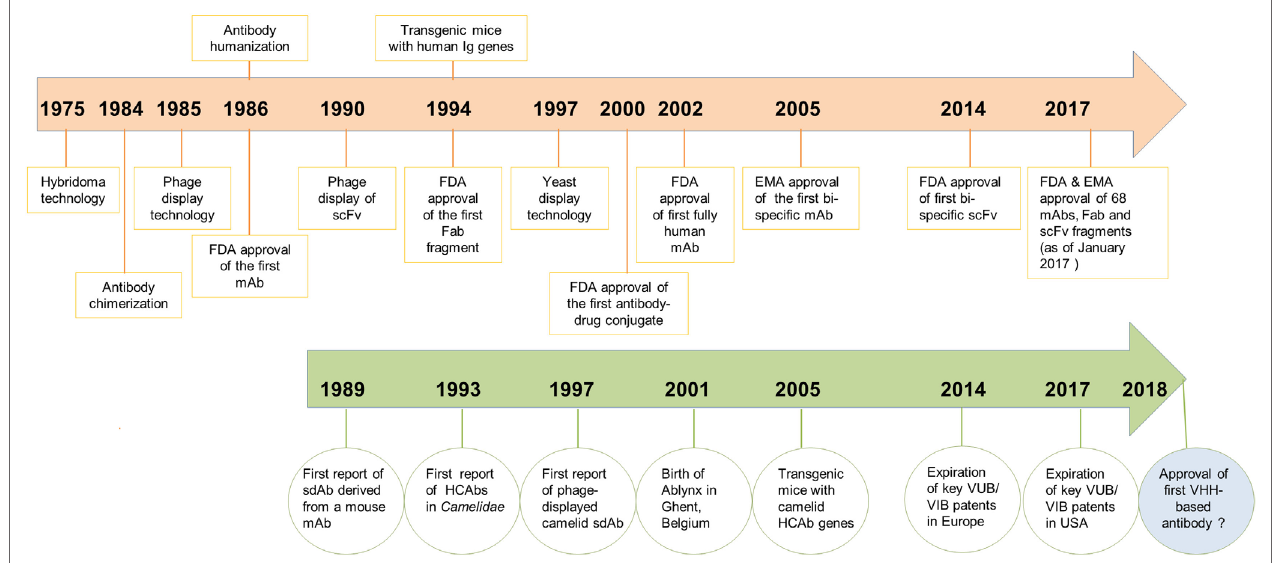
FiGUre 1 | Chronological timeline of major scientific developments in the field of antibody engineering since the discovery of monoclonal antibodies (mAbs) in 1975 leading to the regulatory approval of mAbs, antigen-binding fragments (Fabs) and scFvs as therapeutics. Developments for mAbs are shown in orange and developments of V H Hs/heavy chain-only antibodies (HCAbs) in green. Regulatory approval of the first V H H-based antibody drug is expected in